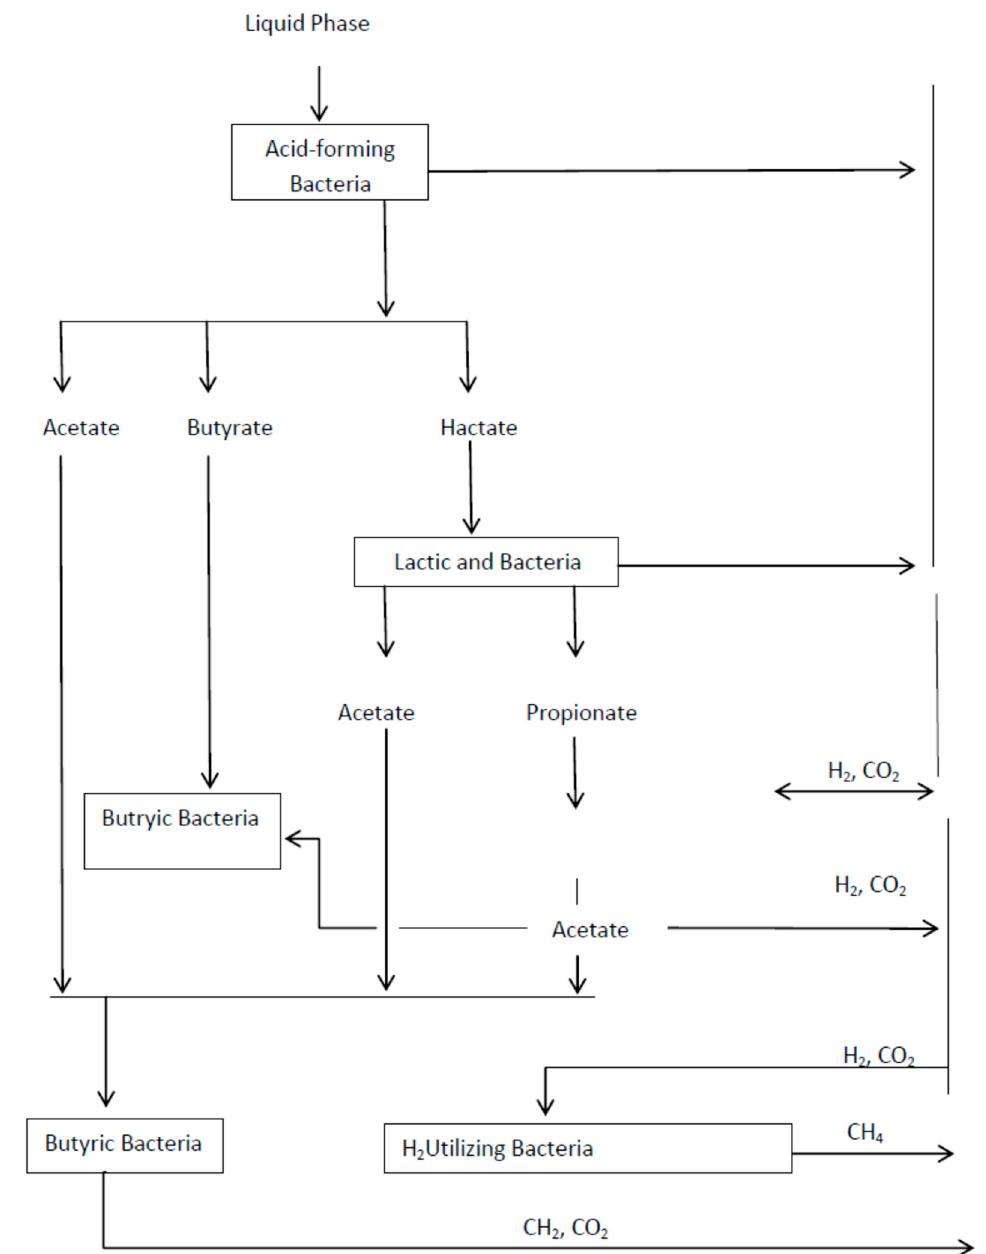
Figure 1. Schematics of the relationships between each group of bacteria in the anaerobic ecosystem.